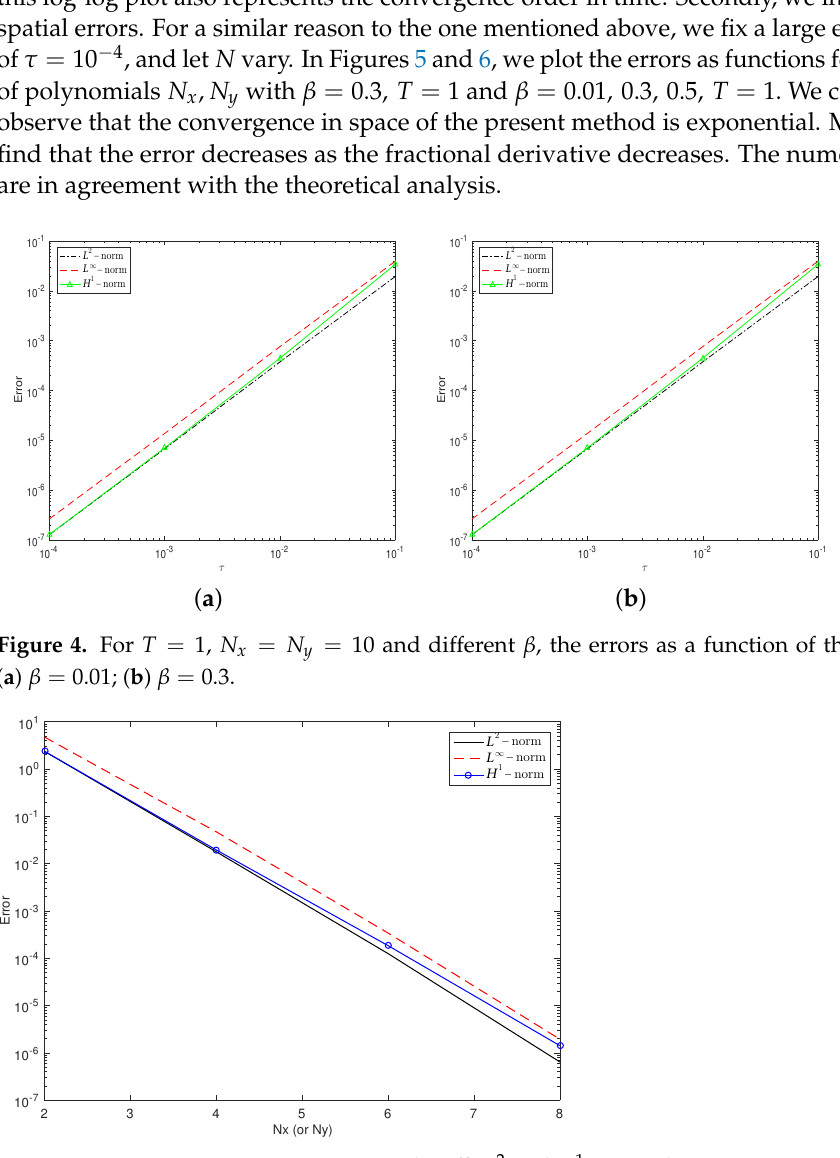
Figure 5. For β = 0.3, τ = 0.0001, T = 1, the L ∞ , L 2 and H 1 errors show an exponential decay with N x , N y